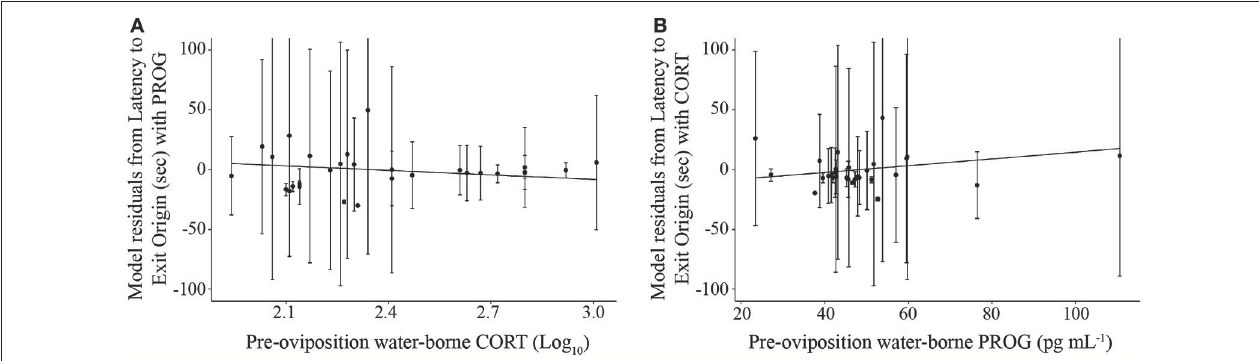
FIGURE 6 | Scatterplot illustrating the relationship between (A) pre-oviposition water-borne corticosterone (log 10 transformed) and mean latency to exit the origin and (B) pre-oviposition water-borne progesterone and mean latency to exit the origin. Each hormone is represented on the x-axis, while the y-axis represents the residuals of the linear mixed effects model for latency to exit the origin with the other hormone as the only variable and frog identification as a mixed effect. Solid lines indicate a significant relationship. Error bars represent standard